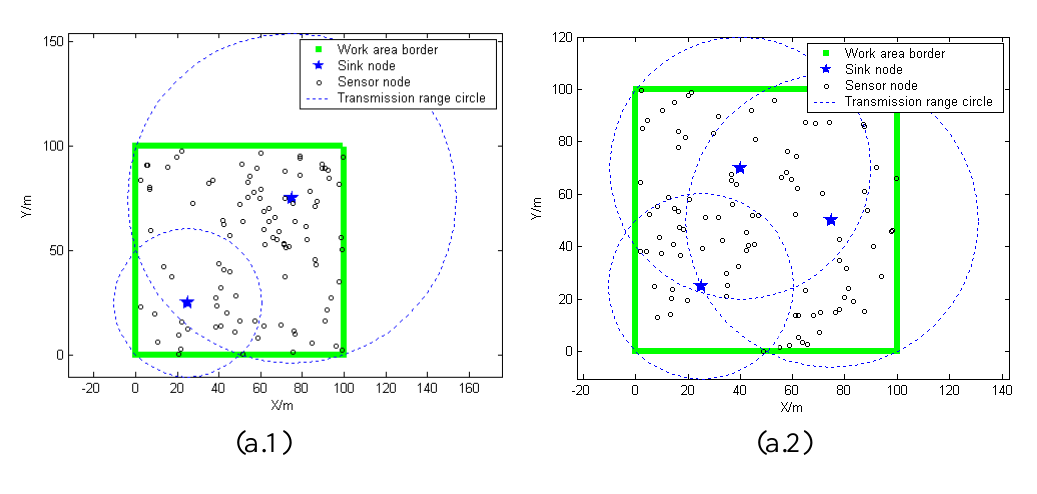
Figure 11. The radio range of sink nodes with power allocation. (a) sink fixed deployment. (b) sink deployment